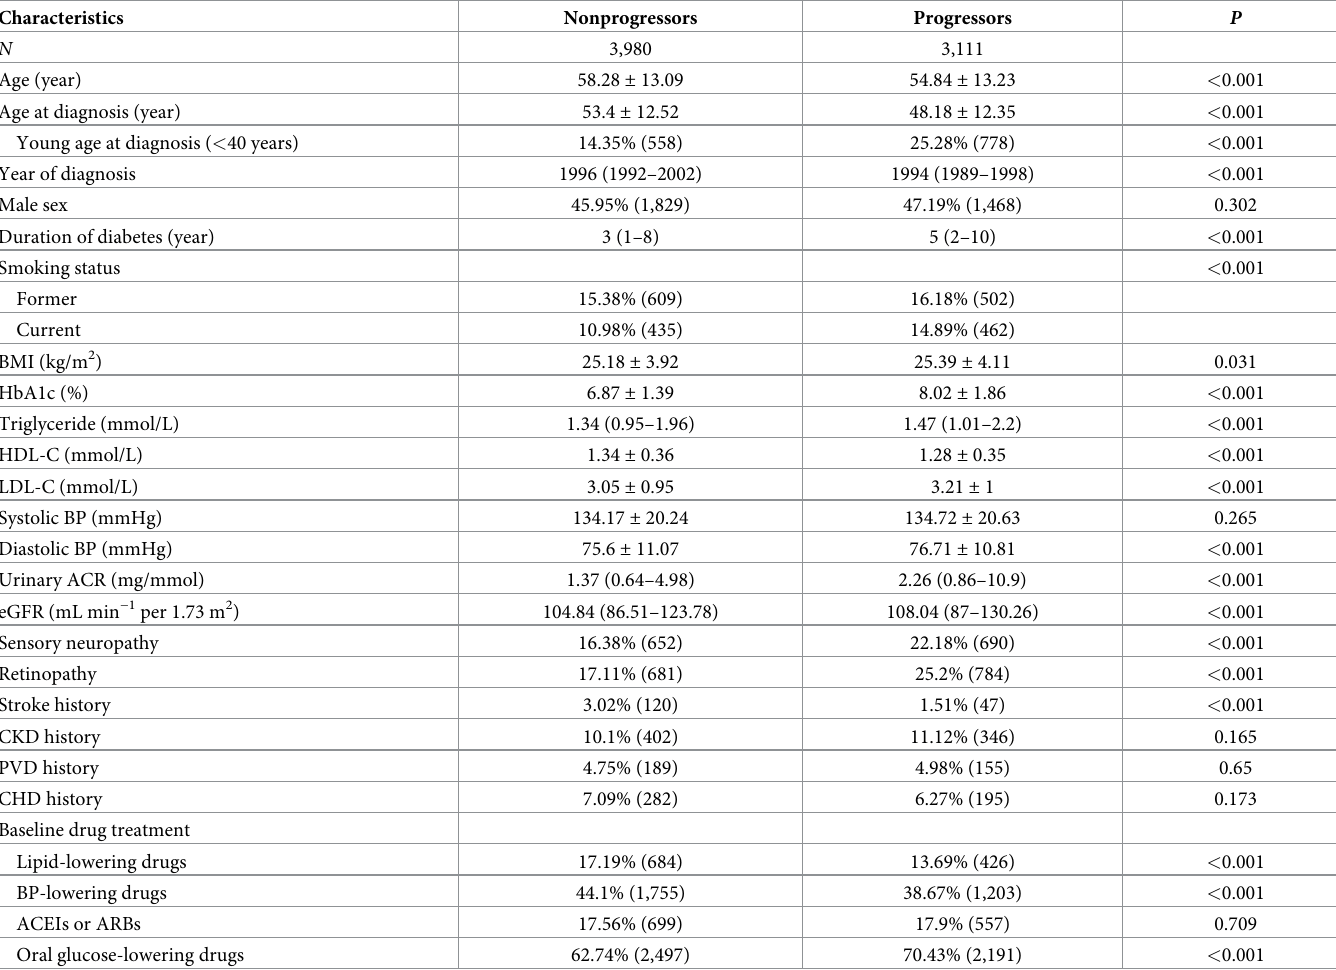
Table 1. Baseline characteristics of progressors and nonprogressors for glycemic deterioraton, defined as need for insulin treatment in the primary cohort.